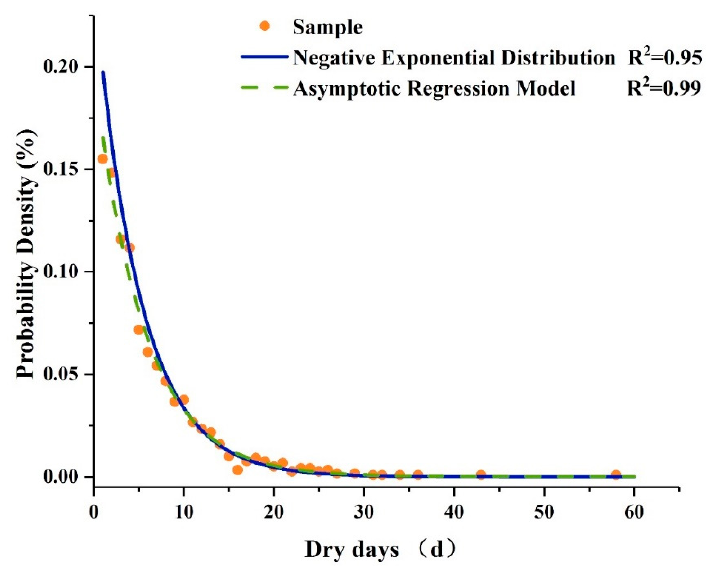
Figure 5. Probability density function of dry days.